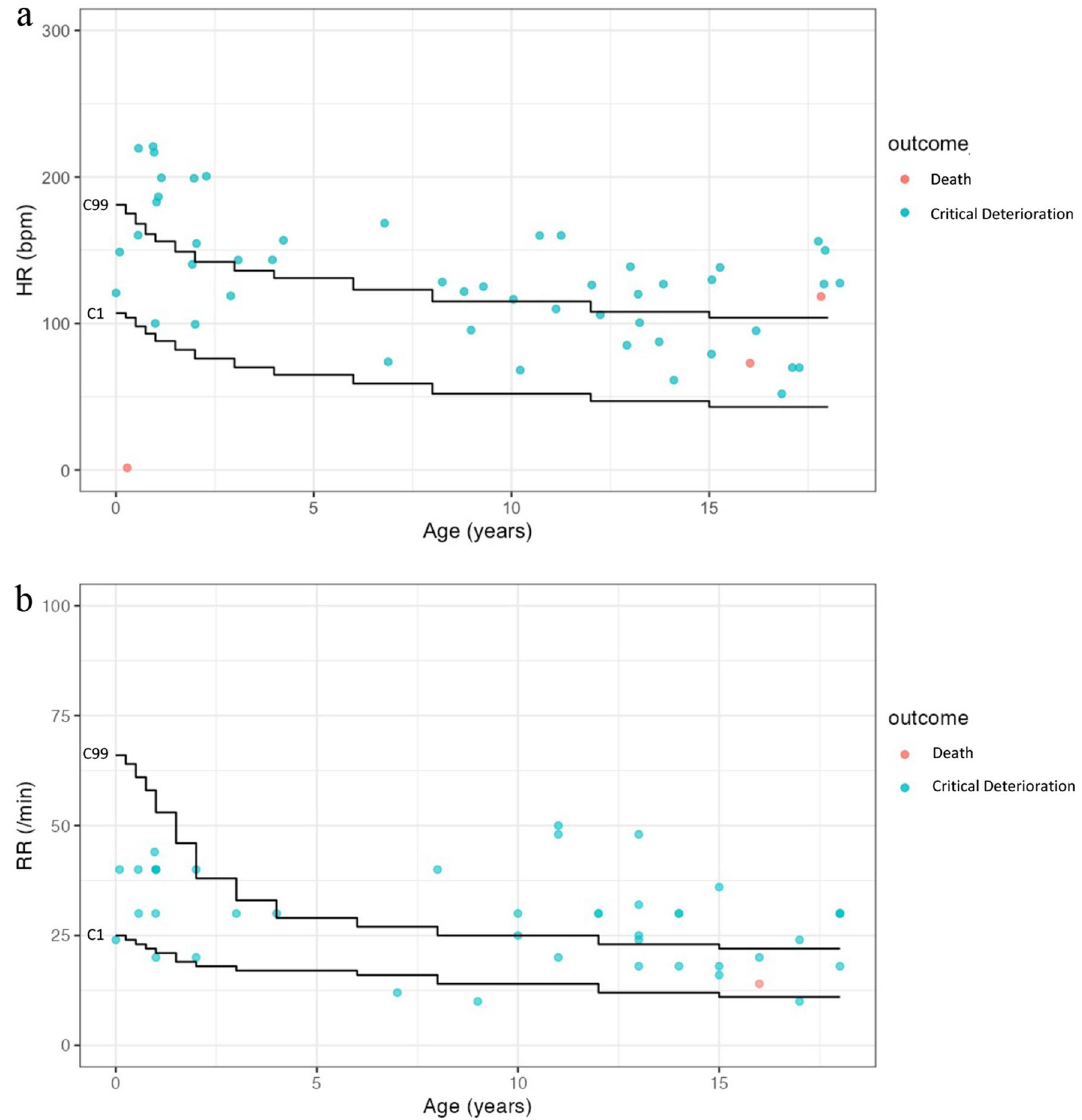
Figure 3. Centile curves of the heart rates ( a ) and respiratory rates ( b ) of healthy children as developed by Fleming et al. 1 and plots of patients who died or were hospitalized with critical deterioration events. Data on patients without vital signs recorded at the two time points by the emergency medical service providers are not displayed here. Critical Deterioration, hospitalized with critical deterioration events; C1, the 1st centile; C99, the 99th centile.